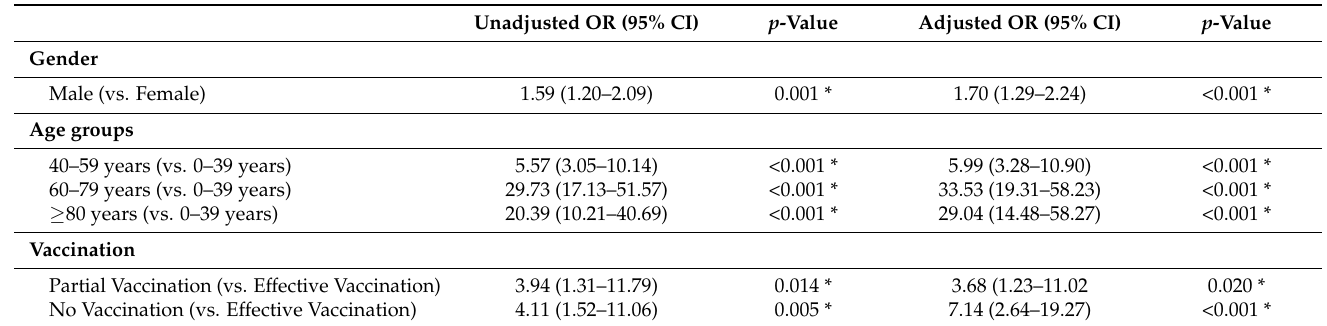
Table 2. Univariate and multivariate logistic regression of the risk of hospitalization in intensive care unit (ICU) caused by